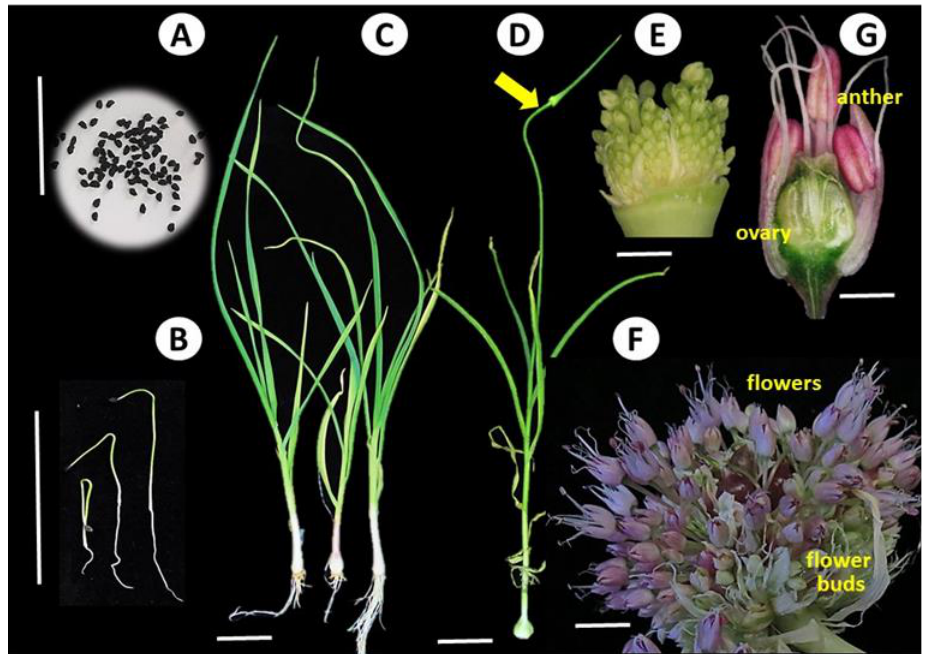
Figure 1. Representative samples of fertile garlic genotypes from true seed to flowering at different stages of development. Scale: A = 3 cm, B, D = 5 cm, C = 2 cm; E, F, G = 1 cm. ( A ) true garlic seeds. ( B ) five days old seedlings. ( C ) adult plants from cloves. ( D ) pre-anthesis garlic plant, with scape and spathe (arrow) visible. ( E ) flowers at early stages of development in the young inflorescence. ( F ) matured inflorescence, older flowers with anthers are visible at the umbel top, young flowers and flower buds are located in the lower part of the inflorescence. ( G ) cross-section of a post-anthesis flower. Anthers and an ovary are visible.